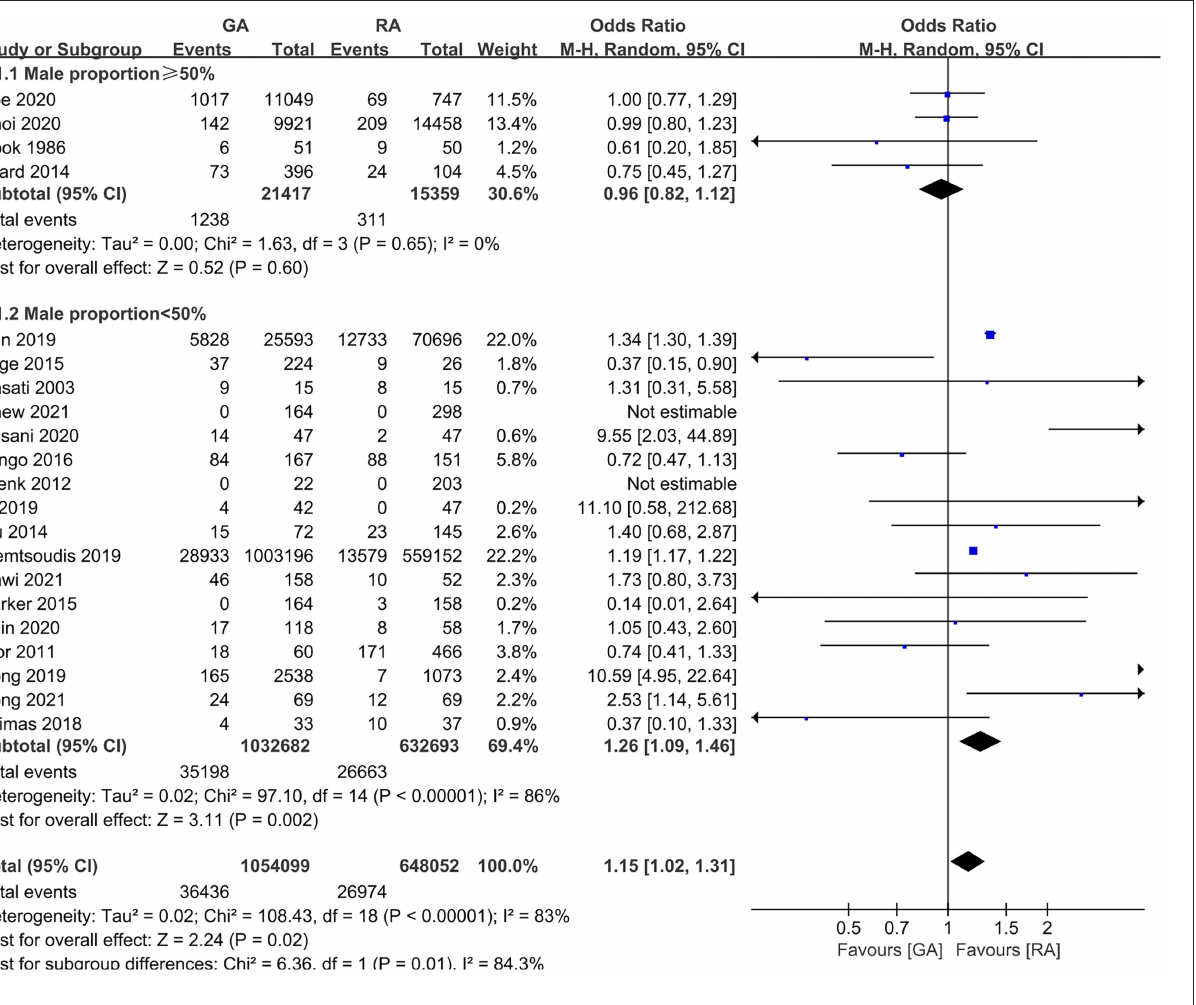
FIGURE 7 | The subgroup analysis according to the male percentage ( ≥ 50 and <